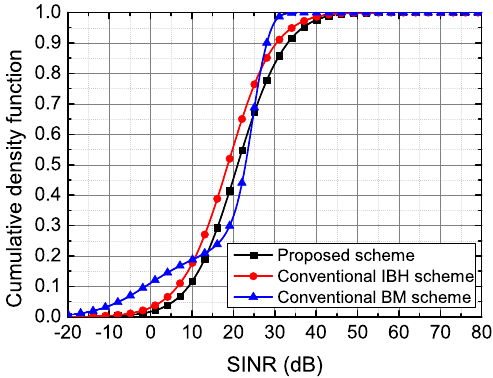
Figure 7. SINR results in relation to 3-schemes in the UDN